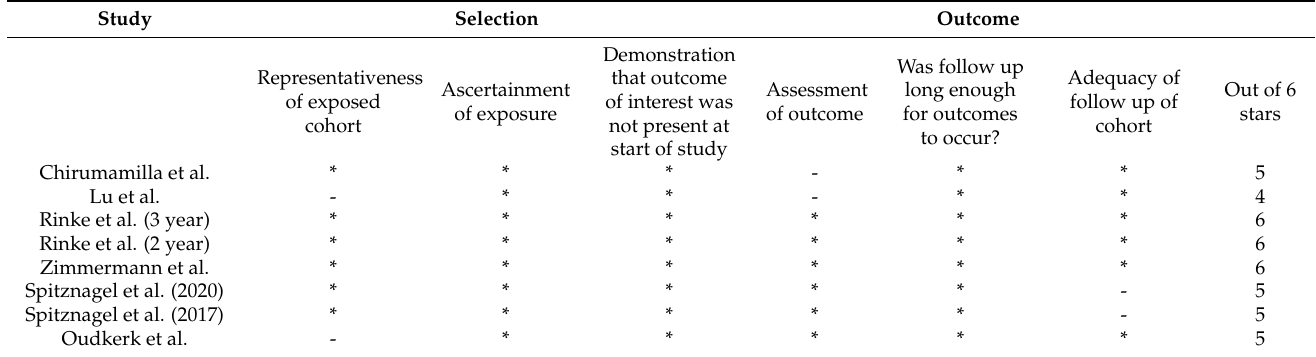
Table 3. Newcastle–Ottawa risk of bias table.